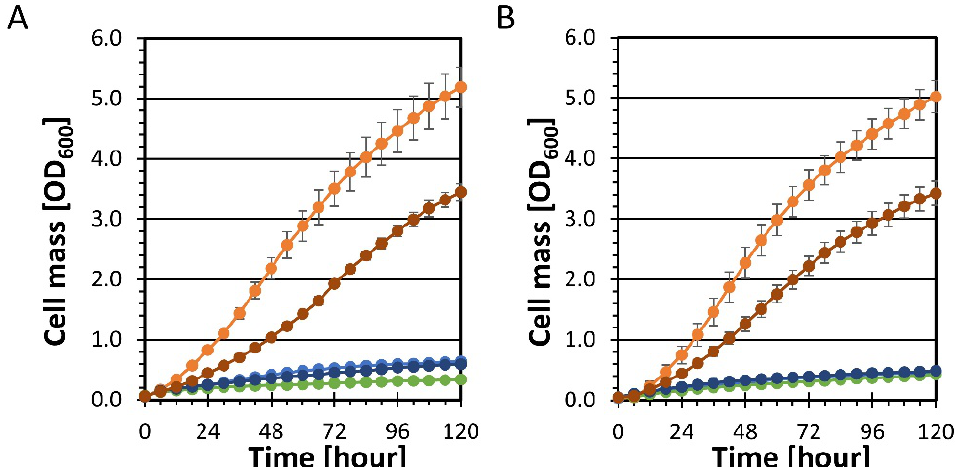
Figure 5. Deletion of both PBS2 and PHO13 are required for enhanced growth on xylose. ( A ) Growth curves for strains with PBS2 or PHO13 deletion in the unadapted parent YRH631. ( B ) Growth curves for strains with PBS2 or PHO13 deletion in the unadapted CEN.PK2-1C strain. YP5X medium was used for both ( A , B ). Plots are the average values from at least triplicate cultures. Error bars show standard deviations. Strain description: Panels ( A , B ) YRH631 (unadapted strain),